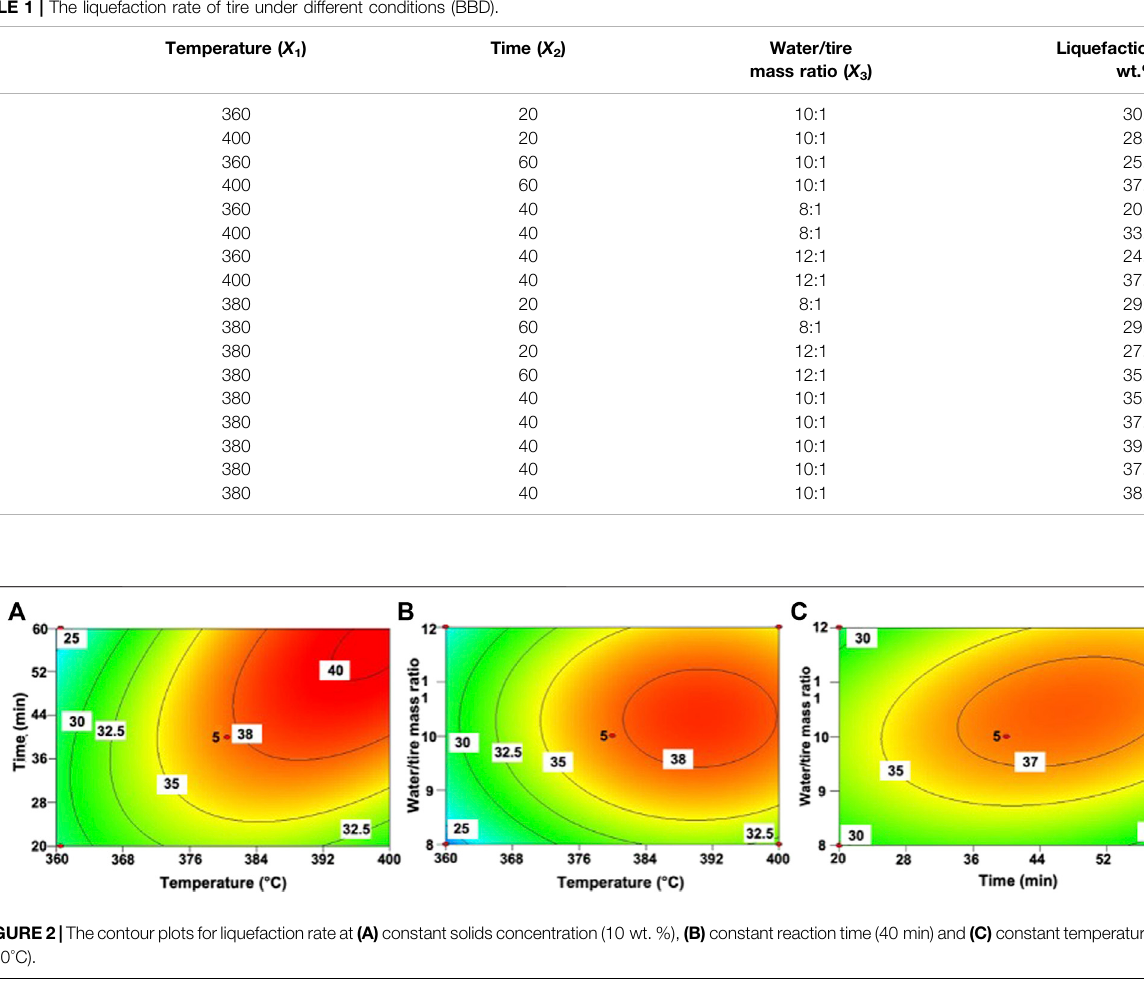
Frontiers in Energy Research |